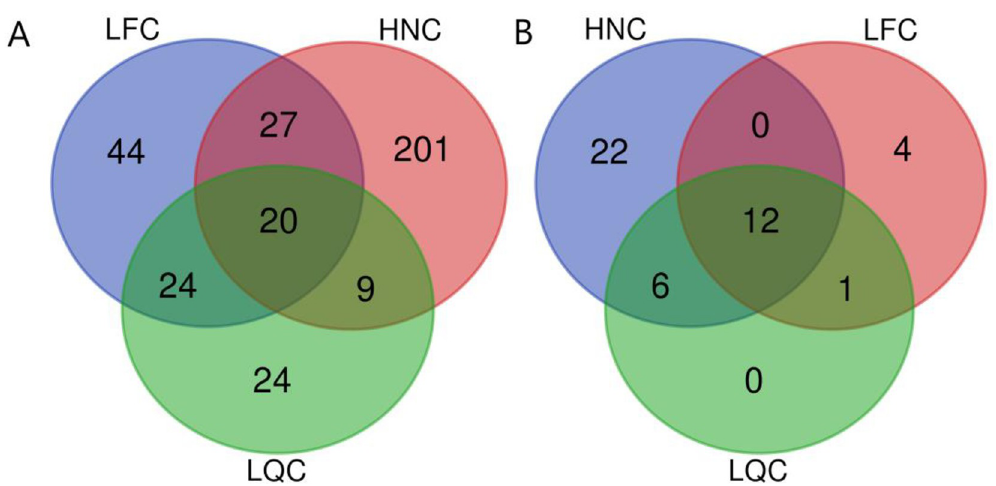
Fig 6. Candidate genes identified for the three populations overlapping with ROH islands. (A) The Venn diagram of the identified genes for three populations when the threshold frequency of ROH islands is set to 0.3. (B) The Venn diagram of the identified genes for three populations when the threshold frequency of ROH islands is set to